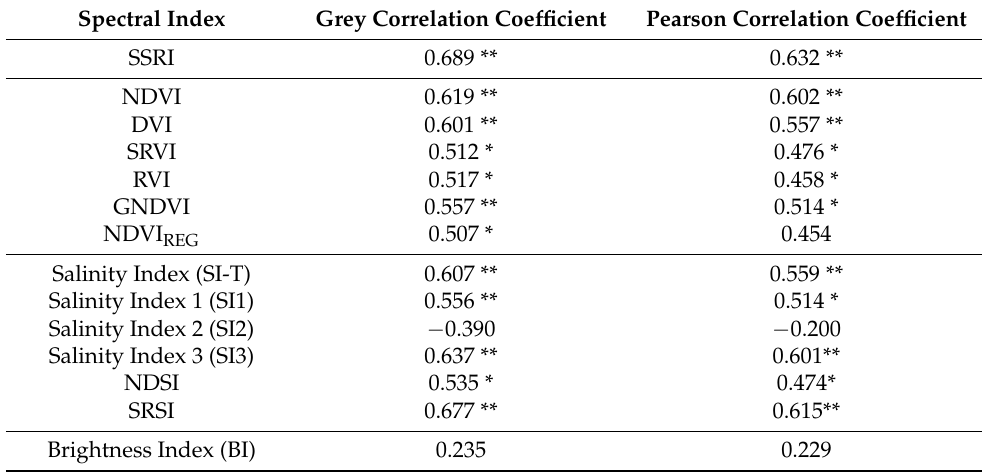
Table 7. Correlation analysis of sensitive spectral index with soil salinity.